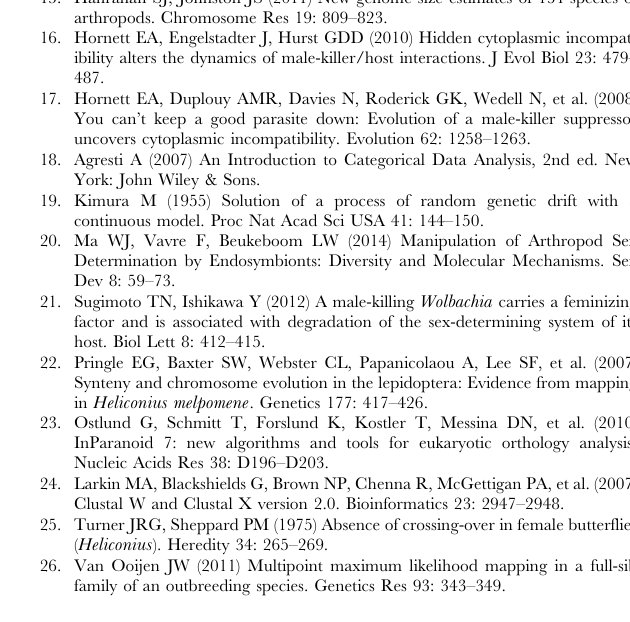
S4 Table Polymorphism statistics and nucleotide diver- sity estimates for the 9 unlinked loci (M-U) for the 2001 and 2006 Samoan population samples. Only SNPs were used in these analyses, indels where excluded. # : number. (TIF) S5 Table F ST analysis of differentiation between 2001 and 2006 Samoan population samples at the nine unlinked loci. (TIF) S6 Table Data generated for linkage mapping. Data for 307 daughters of the male-informative cross in the format required for Joinmap. (XLSX) S7 Table Genotypes for each individual used in the study, for the 12 suppressor-linked markers. Each SNP is denoted using the IUPAC code. Missing data occurred where the sequence was not scorable for that individual. (XLSX) S1 Text Modelling the spread of the